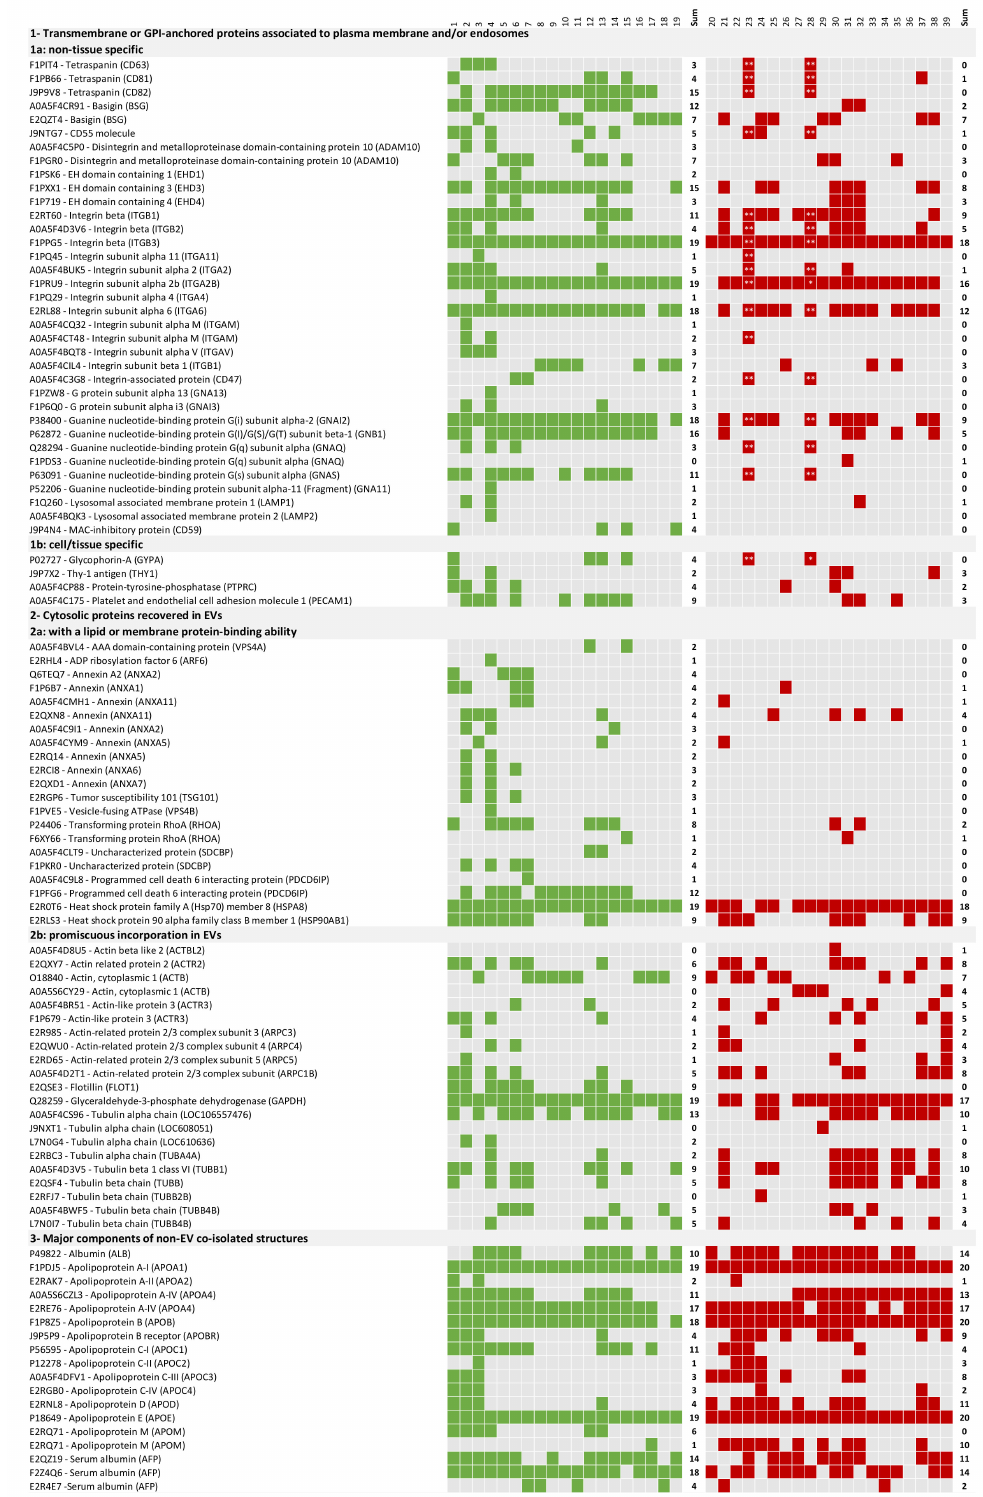
Figure 3. Protein content-EV characterization based on the MISEV2018 guidelines. Each line repre- sents a protein, while the columns labelled with a number represent the individual samples. The presence of green (Healthy group) or red (CanL group) colors associated to individual proteins depicted in lines represents the detection of that protein in the sample with at least 2 unique peptides. For samples 23 and 28, proteins with one unique peptide (*) and spectrums identified (**) were also